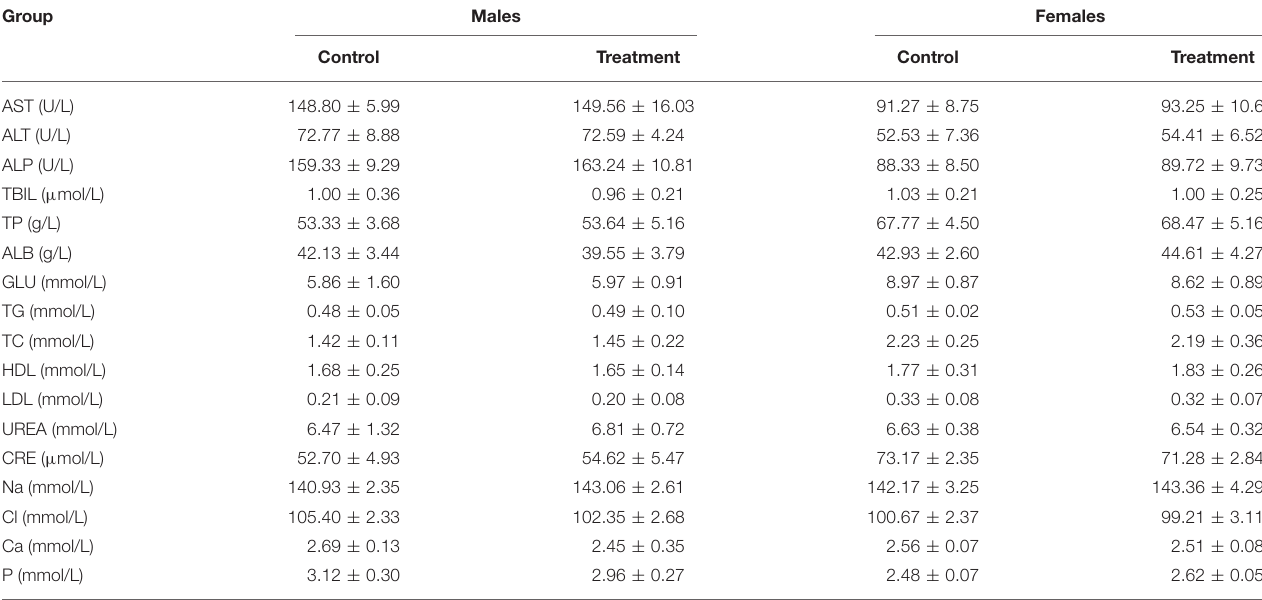
TABLE 5 | Serum biochemical parameters of male and female rats after oral administration of Enterococcus durans KLDS6.0930 for 28 days. Group Males Females Control Treatment Control Treatment